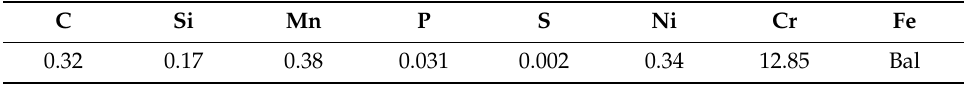
Table 1. Chemical compositions of as-received SUS420J2 steel in this study, mass%.